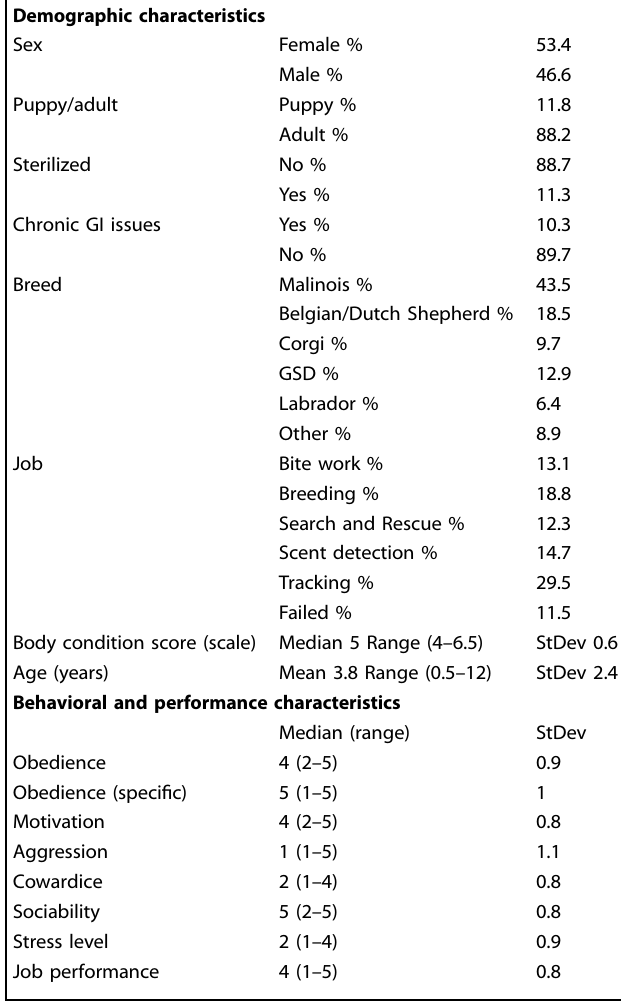
Fig. 2 Relative value of microbiome features that differed by the sterilization status (Dog was spayed/neutered or not) of the dog and are statistically signi fi cant (only associations signi fi cant via by Mann – Whitney test, p < 0.05, are included). A Re fl ects differ- ential value of richness and diversity, and B re fl ects relative abundance. Error bars represent con fi dence